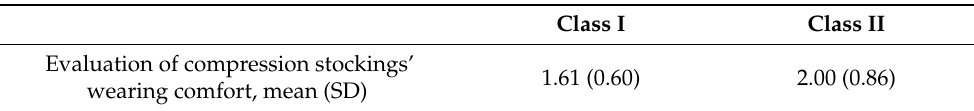
Table 6. Mean and SD of wearing comfort of the medical device (with 1 indicating very good and 6 insufficient wearing